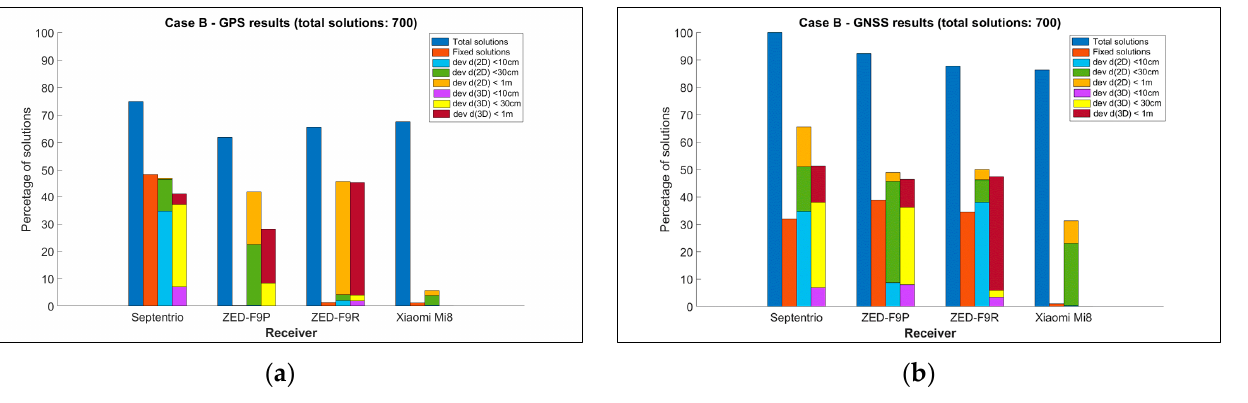
Figure 12. Percentage of solutions for Case B for ( a ) GPS solutions; ( b ) GNSS solutions. Each bar in a group shows: available solutions (1st bar), percentage of fixed solutions (2nd bar), deviation at horizontal distances (3rd bar, where light blue is for thresholds less than 10 cm, green is for thresholds less than 30 cm, and brown is for thresholds less than 1 m), and 4th bar shows deviation at spatial distances (yellow, green, and dark red for 10 cm, 30 cm, and 1 m thresholds, respectively).